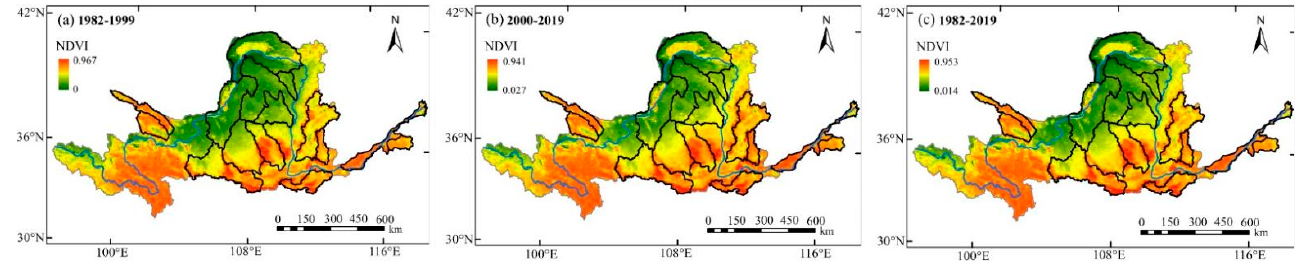
Figure 8. Spatial patterns of the normal difference vegetation index (NDVI) in different time periods in the Yellow River Basin (YRB). ( a ) 1982–1999, ( b ) 2000–2019, and ( c ) 1982–2019. in the Yellow River Basin (YRB). ( a ) 1982–1999, ( b ) 2000–2019, and ( c )